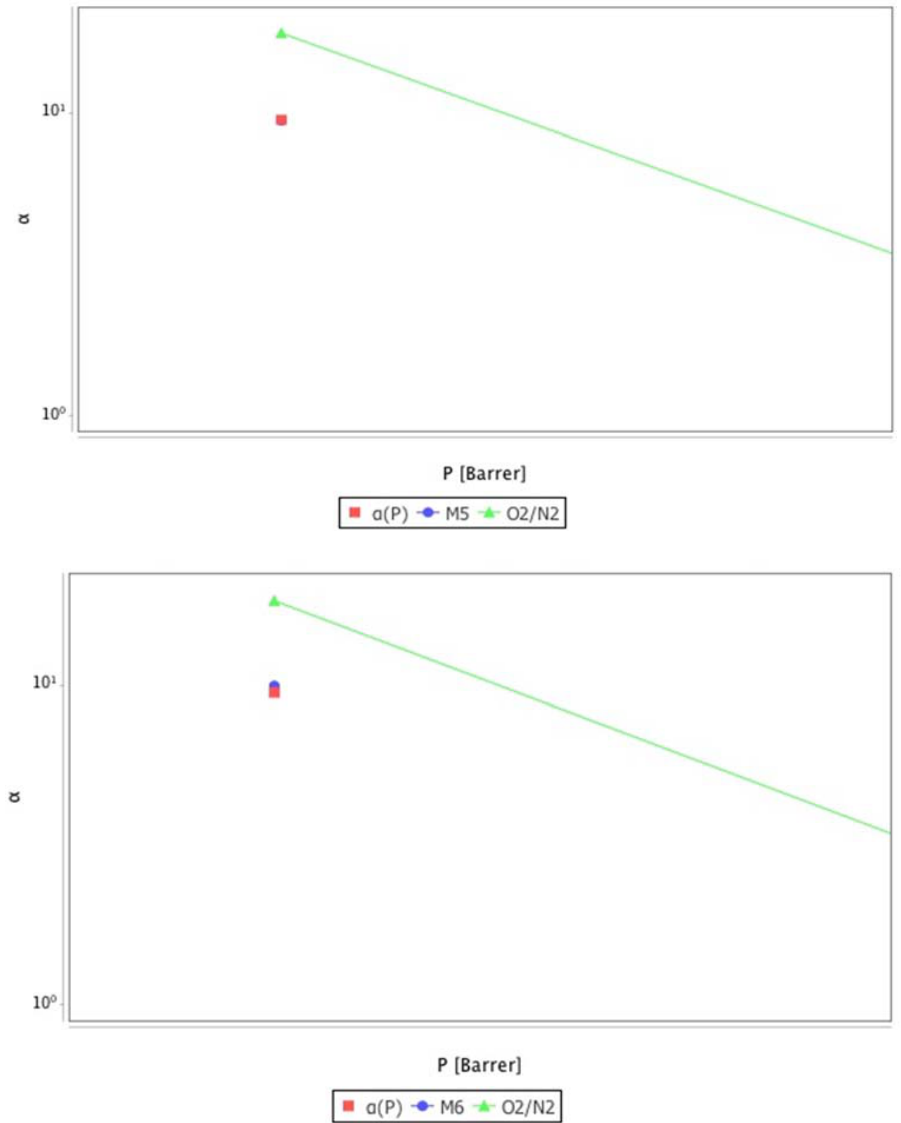
Figure 8. Comparison of experimental results (navy blue point) for the zeolite 4A-HBPI mixed-matrix membranes with 6 different filler additions (M1–M6) with Maxwell theoretical results (red point) and their position relative to the Robeson upper bound line (green line).